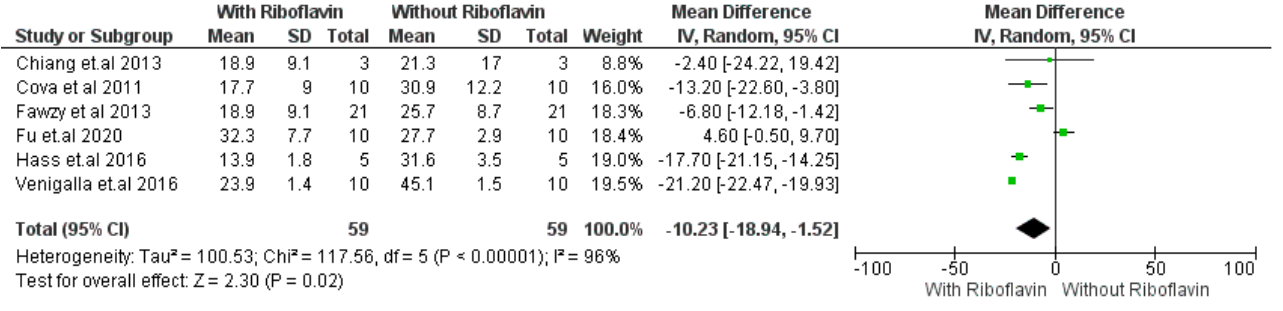
Figure 3. Forest plot of micro tensile strength property of adhesive with 0.1% RF crosslinker. Meta-analysis was conducted with six studies. The meta-analysis evaluated the micro tensile bond strength of the dentin bonding system with and without the use of riboflavin [18,23,26,30–32] after prolonged (6 months) storage.